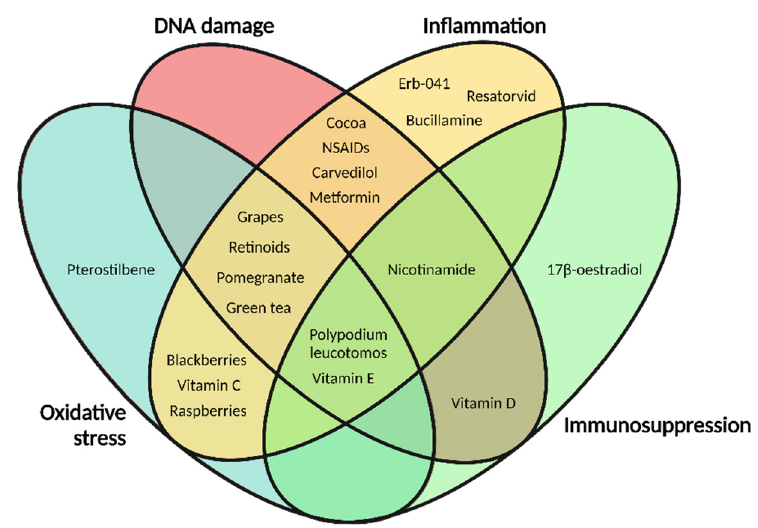
Figure 3. Overview of the reviewed compounds and their mechanisms. The Venn diagram represents four of the five UV-induced events (DNA damage, oxidative stress, inflammation and immunosuppression). UV-induced events targeted by each compound are shown. Dysregulated signal transduction is not included in the figure as it can be reflected as induction and stimulation of the other four UV-induced events. Abbreviations: NSAIDs, non-steroidal anti-inflammatory drugs. Numerous of studies have explored the extensive possibilities of photoprotectants, and through thorough investigations focusing on the various mechanisms of action following oral delivery, the challenge will now be to identify the most promising candidates to provide the best possible photoprotection to prevent skin